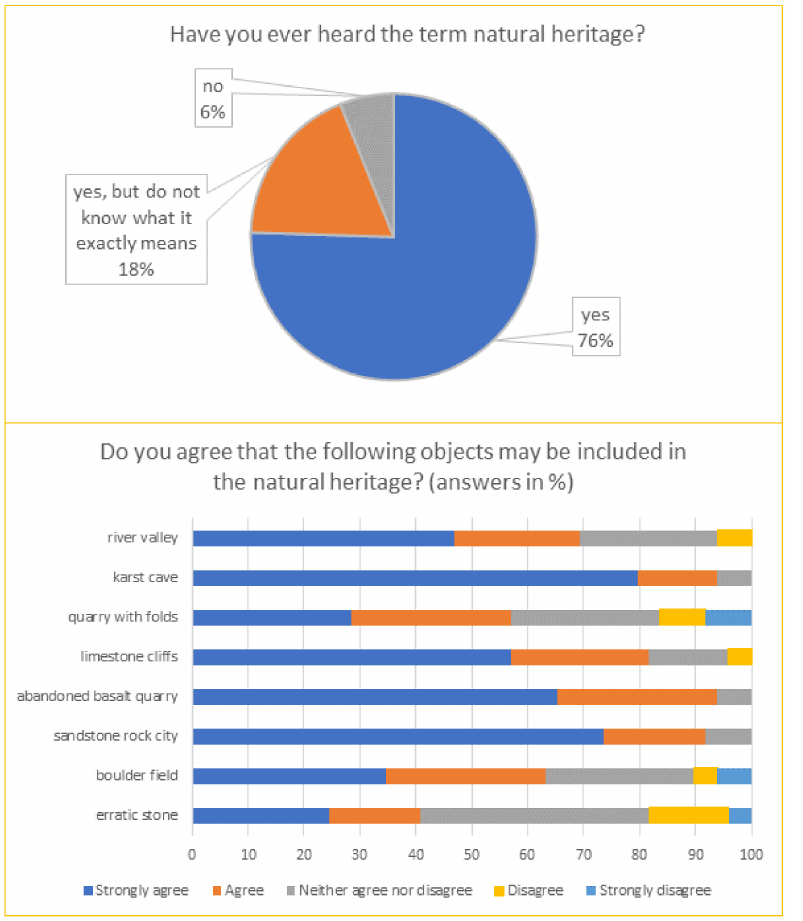
Figure 3. According to the survey, the karst caves and sandstone rock cities are those that deserve protection and inclusion into the natural